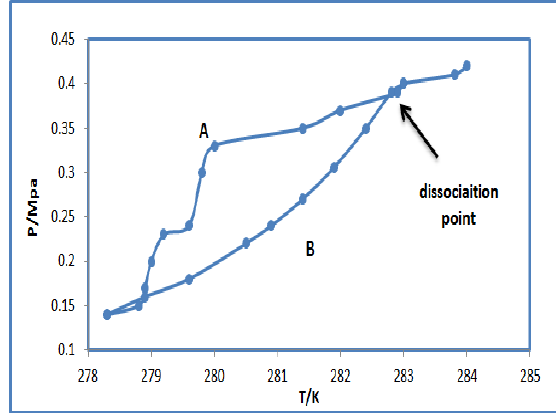
Fig. 5. Pressure vs. temperature equilibrium curves for R134a - water system at hydrates stability conditions.